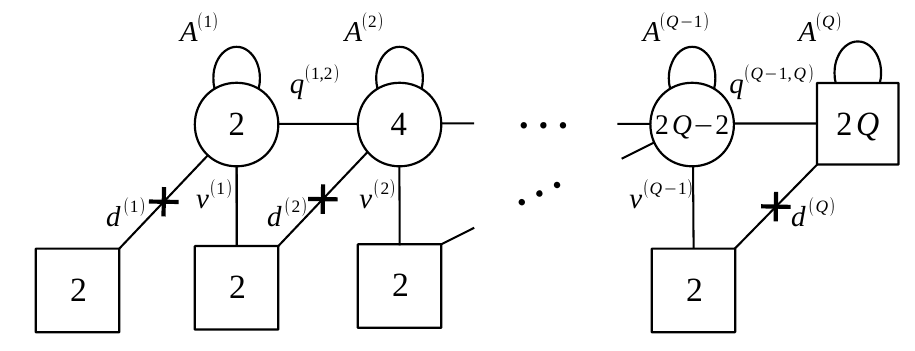
Figure 3: Fields in the E [ USp ( 2 Q )] theory. The crosses represent the gauge singlet fields b n